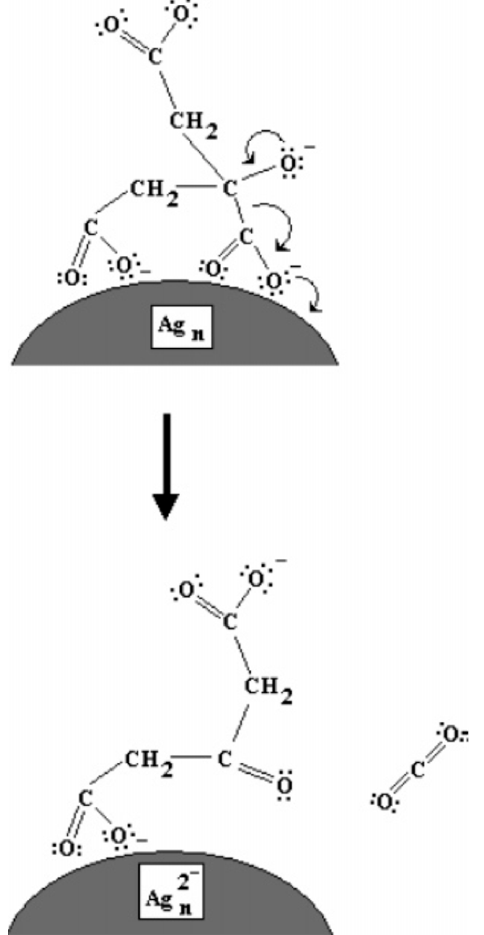
Figure 3. Mechanism proposed by Redmond et al. for the photoreduction of Ag NPs by photoxidation of citrate on their surface. Reprinted with permission from ref. [17]. Copyright 2007 American Chemical